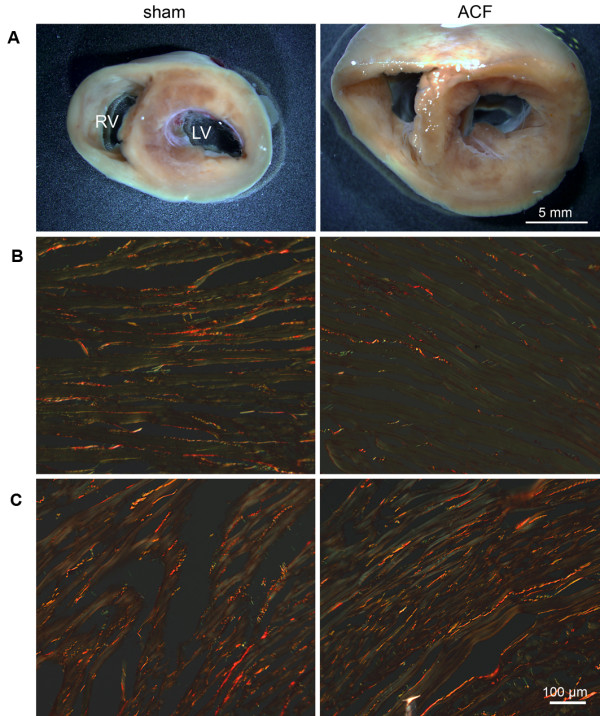
Morphology of sham and ACF rat hearts 150 day after ACF creation. A) Transversal section of the heart illustrates marked biventricular enlargement in the ACF animal compared to control sham-operated rats. B,C) Picrosirius Red staining in transverse sections, observed in polarized light, detected sparse mature collagen fibers (in red) well aligned with the myocyte bundles in the circular layer of the left ventricle (B). The amount of collagen was consistently higher in the right ventricle (C), but no difference between sham and ACF hearts was apparent. Green staining is due to erythrocytes, contractile proteins, or immature collagen fibrils. Very little green was observed at the edges of the collagen fibers, representing physiological protein turnover rather than tissue remodeling, with no difference between sham and ACF.